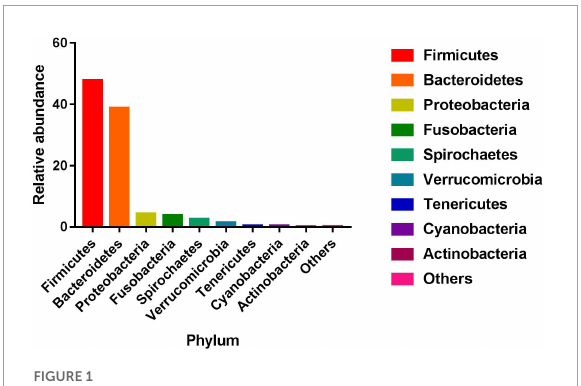
FIGURE1 Phylum of relative